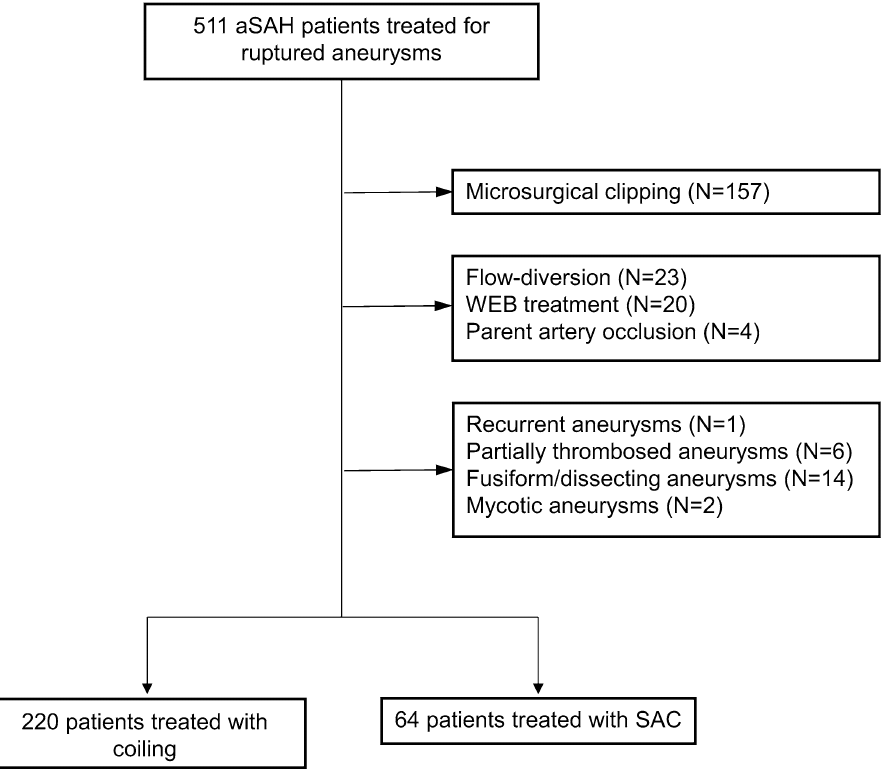
Figure 1. Flow chart of patient selection. aSAH, aneurysmal subarachnoid hemorrhage; WEB, Woven Endobridge; SAC, stent-assisted